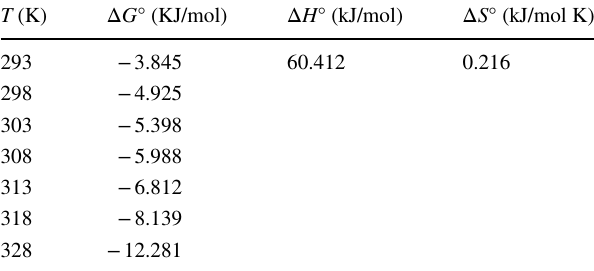
Table 4 Thermodynamic parameters Δ G °, Δ H ° and Δ S ° of As(III) adsorbed on the used cigarette filter ash T (K)